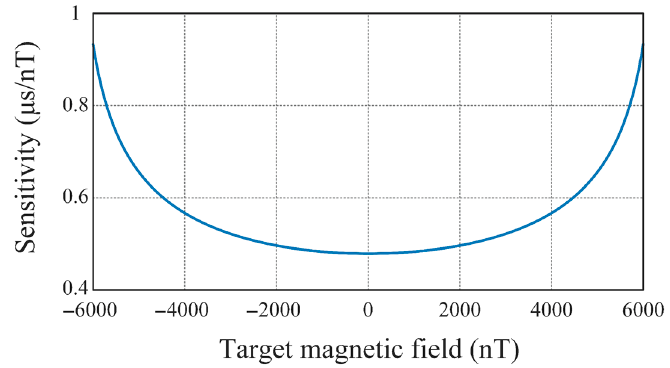
Figure 8. Relationship between sensitivity of RTD fluxgate magnetometer and target magnetic field. Because of this relationship, the RTD fluxgate magnetometer can only be applied in detecting weak magnetic field.